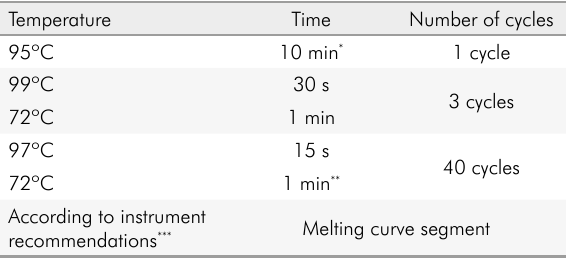
Table 3. PCR cycling